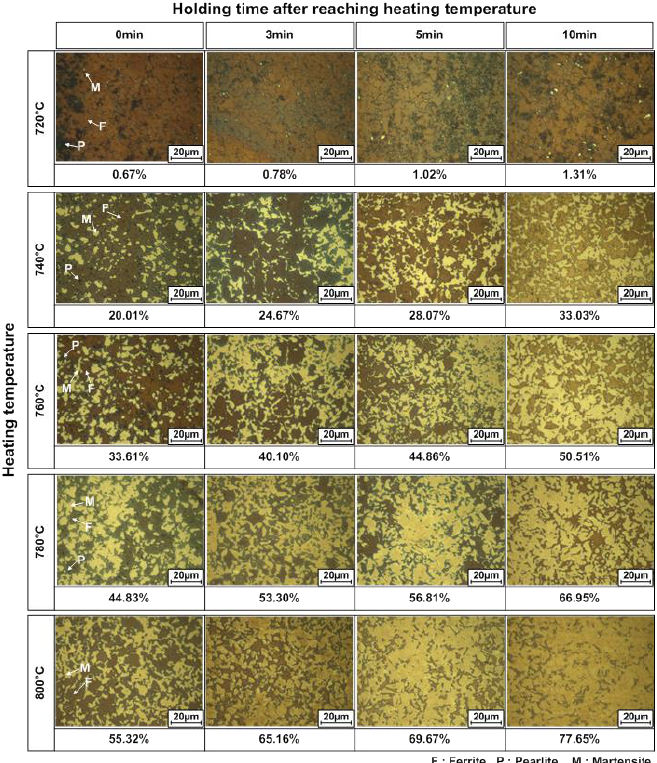
Figure 1. Measured volume fraction of austenite according to the heating temperature and time.